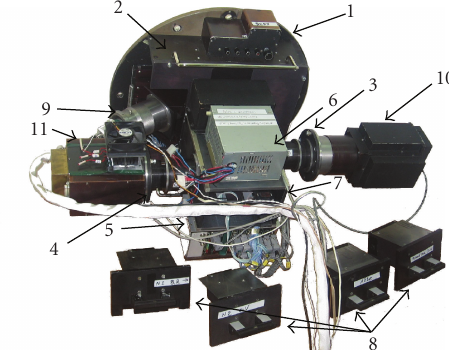
Figure 5: Overview of the Multimode Panoramic PhotoSpectroPo- larimeter (MPPP). 1: telescope mounting flange; 2: focal plane unit; 3 and 4: flanges for mounting the Position-Sensitive Detectors or EM-CCDs; 5: instrument state and motors control unit; 6: power supply; 7: mount point for interchangeable light transformation units; 8: set of optical units; 9: TV-CCD guide; 10 and 11: two PSDs, which may be replaced with